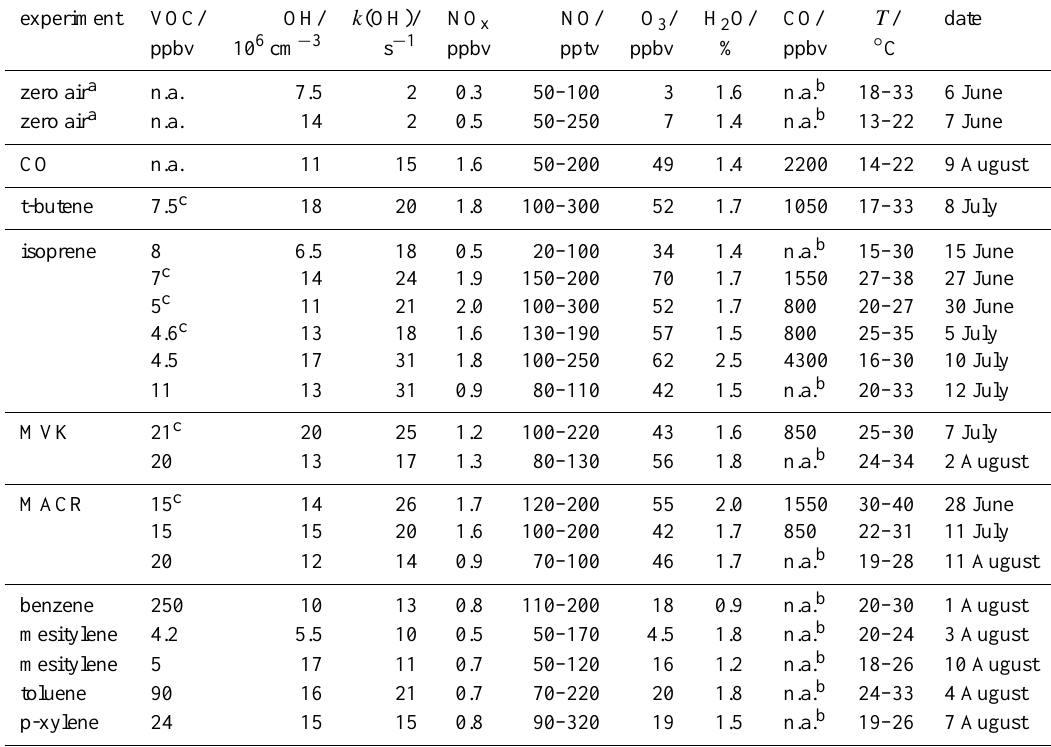
Table 2. Chemical conditions during experiments in SAPHIR when LIF and DOAS measured together. Maximum values are denoted if no range is given. NO, O 3 , CO, and H 2 O mixing ratios were relatively constant over the course of an experiment. CO mixing ratios are only noted if CO was added during the experiment. Methane (50 to 60ppmv) was added in some experiments for the last 1 to 2h. k (OH) is the measured total OH reactivity including reactivity from added reactants, background reactivity in the chamber and the reactivity of products of the VOC degradation. If ozone was added during the experiment, NO concentrations are given for the period after the ozone addition when the photostationary state between O 3 and NO 2 was